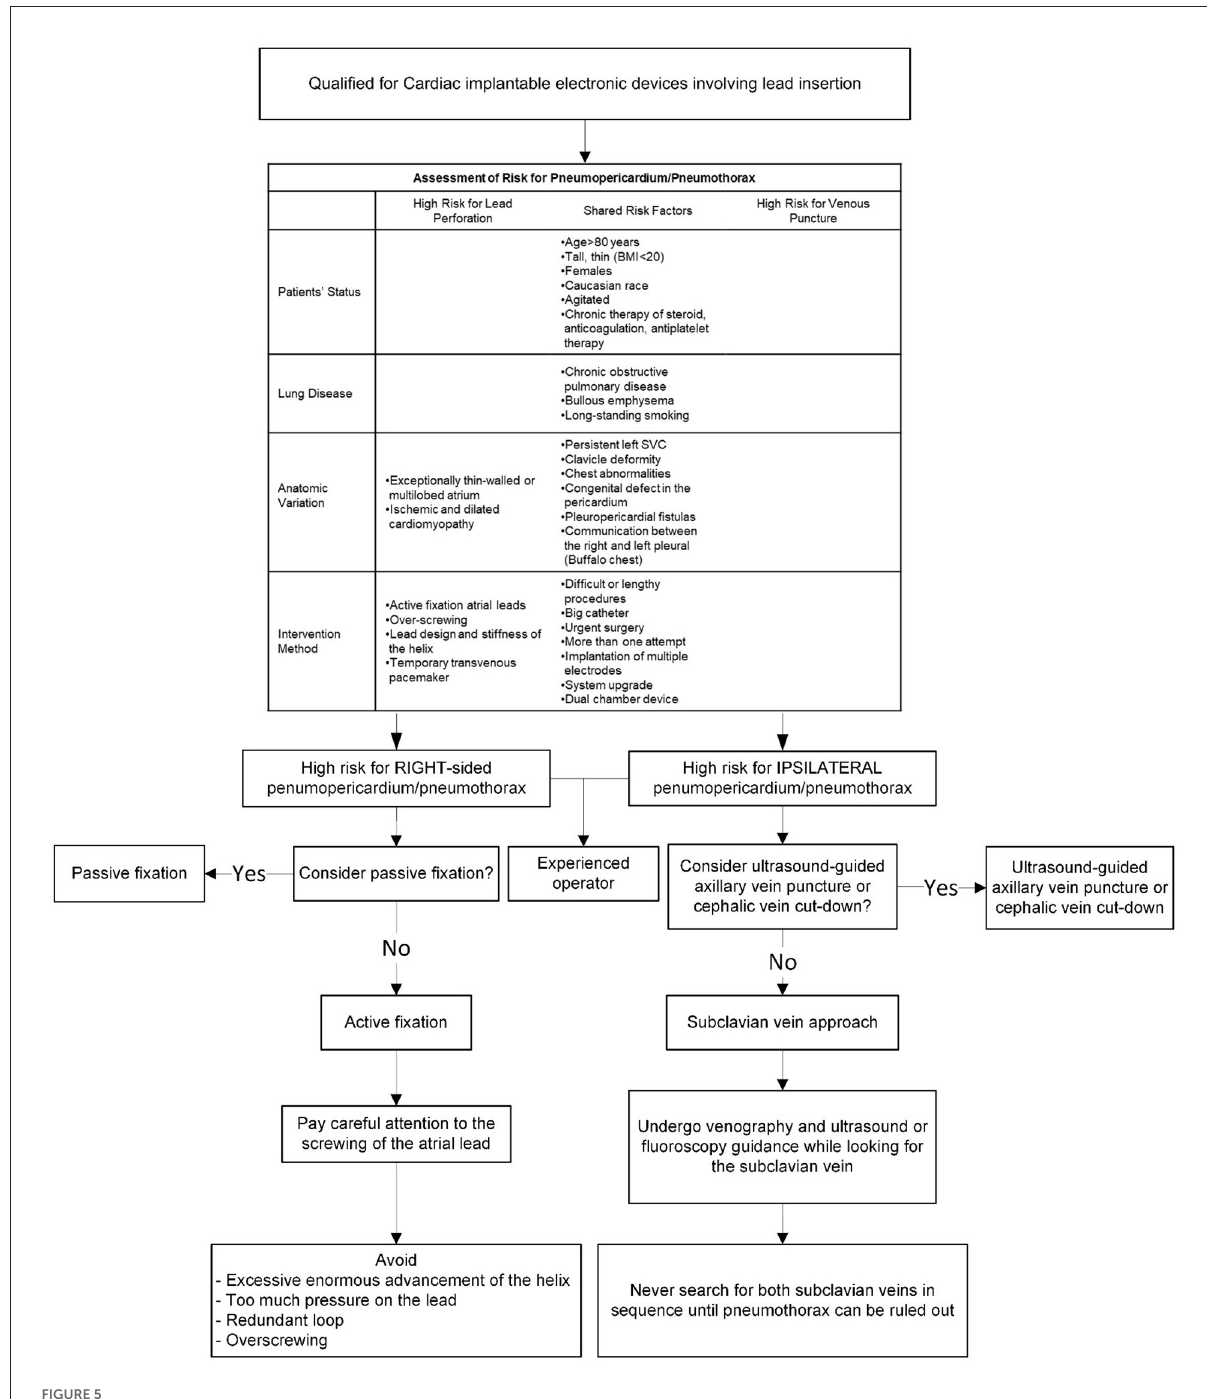
FIGURE5 A clinical algorithm for early identification of patients at high risk of developing pneumothorax or pneumopericardium and corresponding preventive measures.